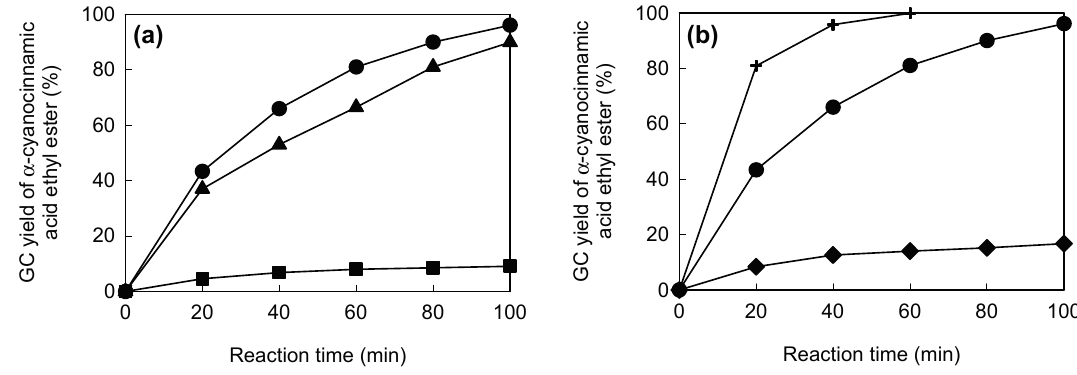
Figure 5. ( a ) Gas chromatographic (GC) yields of target product in batch mode: